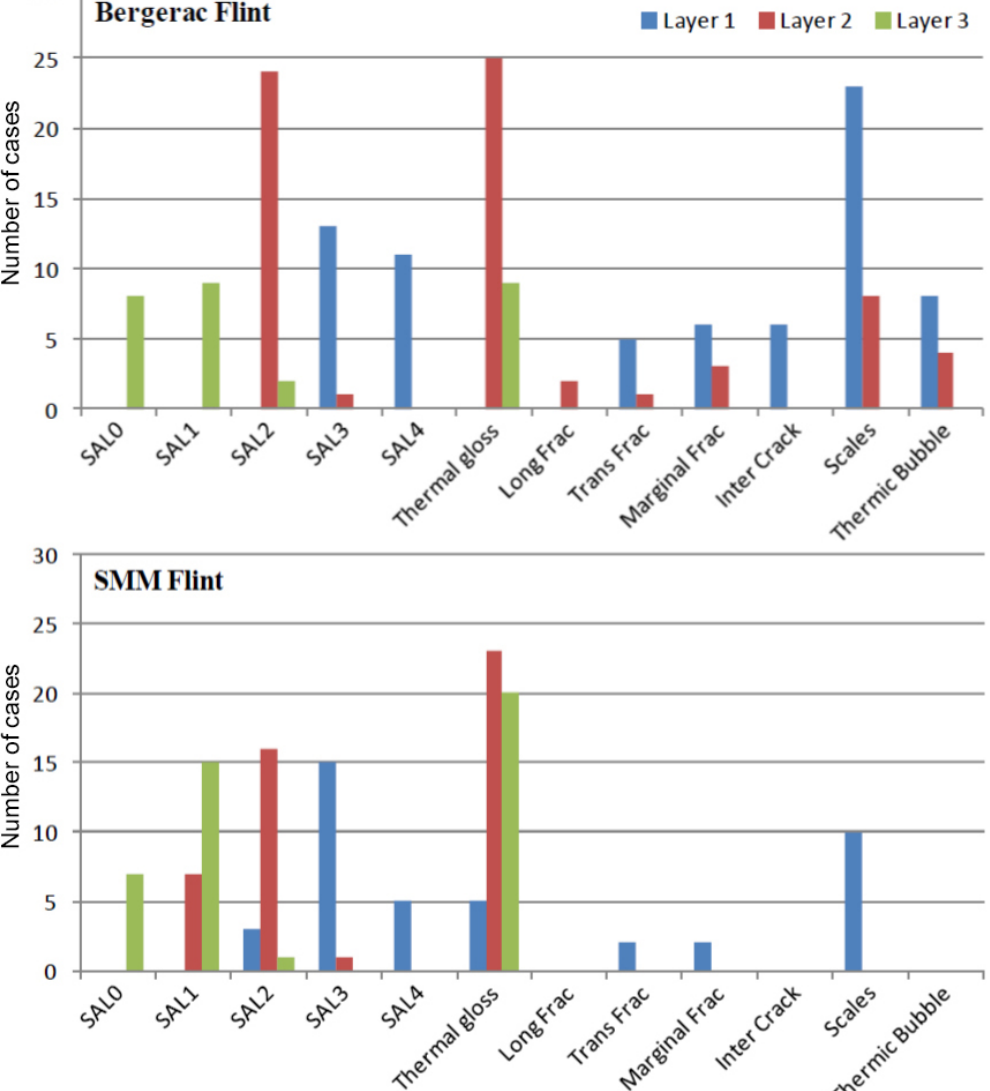
Figure 8. Presence or absence table of occurrence of cases for SAL and heat alteration features according to layer